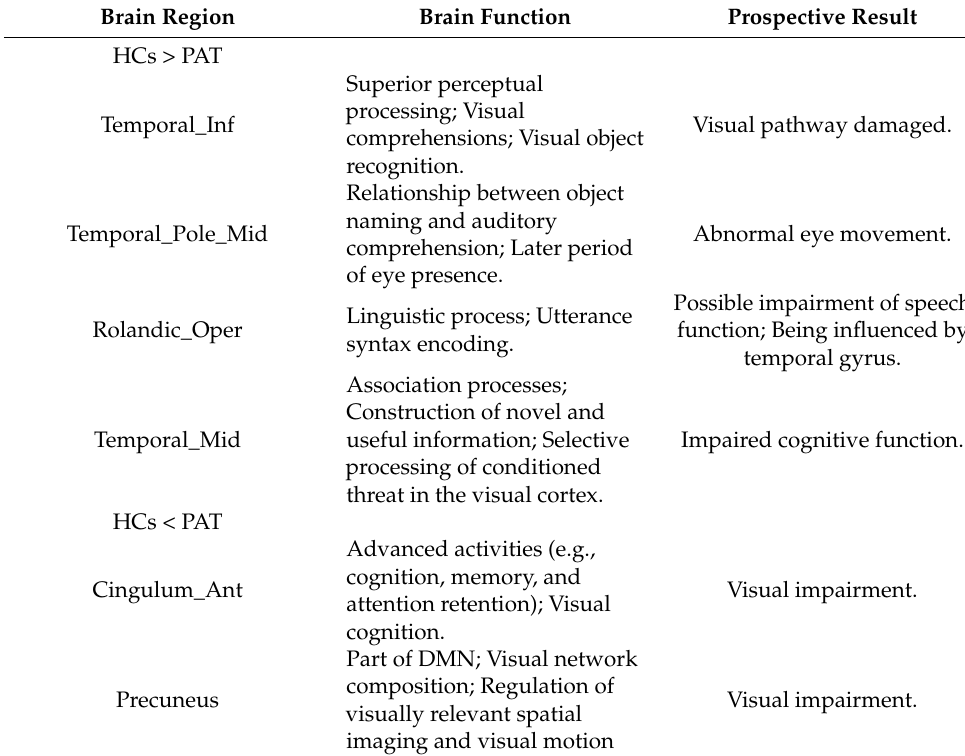
Table 3. Brain regions with changed VMHC values and its potential